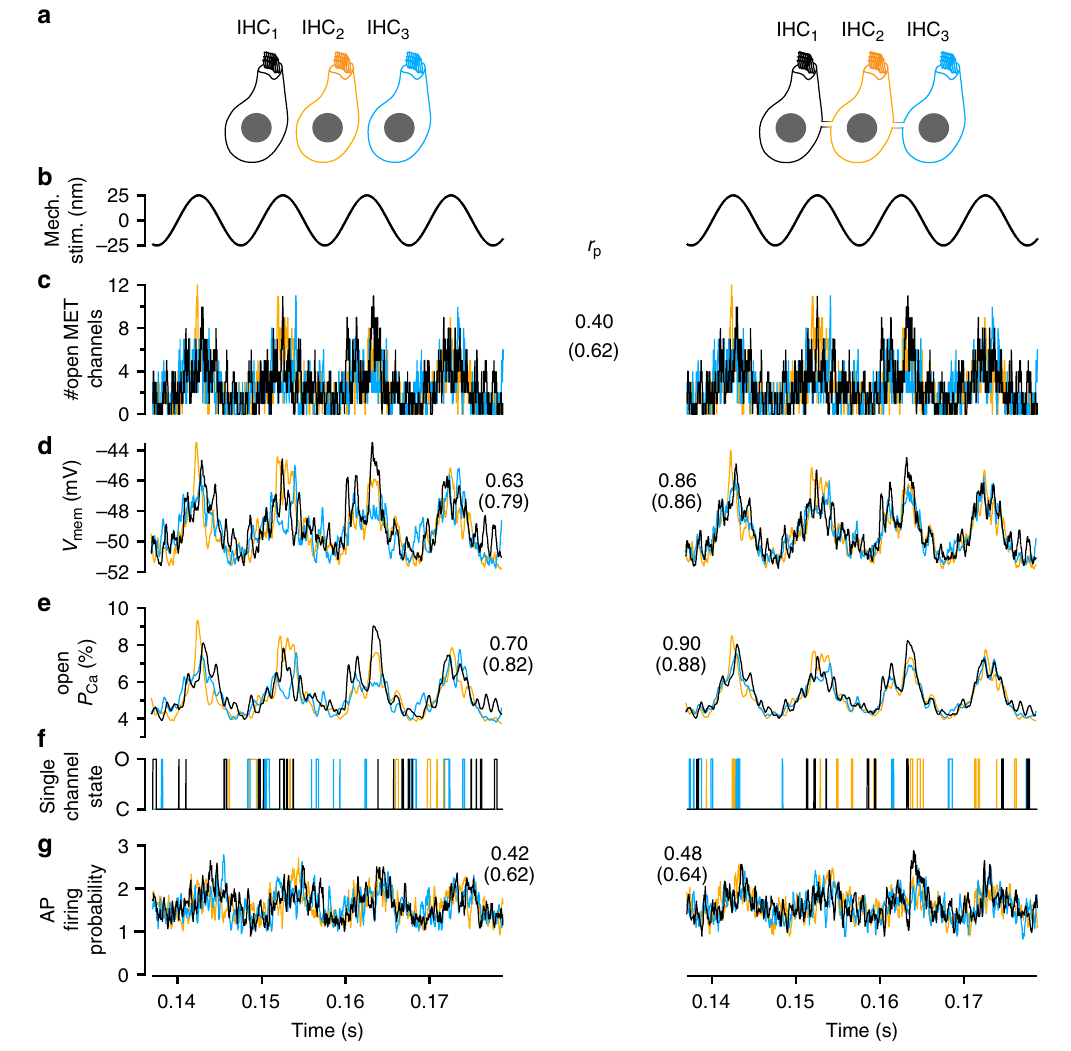
Fig. 8 Electrical IHC coupling coordinates Ca 2 + channel activity. The signaling steps of IHCs and their synapses, simulated in the Neuron modeling environment for three non-coupled IHCs (left) and three coupled IHCs with a junctional resistance of 25 M Ω (right). a Simpli fi ed representation of IHCs, color-coded for the simulation results presented below. b Depiction of the sinusoidal mechanical stimulus (identical for all three cells). c Realization of the stochastic gating of mechanotransducer channels (speci fi c for each cell, identical for coupled and uncoupled cells). d Membrane voltage variations of the three IHCs. They differ from each other because the mechanotransduction currents differ, but that difference is mitigated by electric coupling (right). e Illustration of the average open probability, as would result from very many realizations of Ca 2 + channel gating given the voltage trajectories above. f Different conductance states (O open, C closed) of one channel in each IHC. g Modeling stimulus-secretion-coupling and refractoriness for 35,000 independent realizations of ( f ), an approximate probability to observe an AP in a SGN during a 200 µ s window is calculated. Numbers in the central column are Pearson correlation coef fi cients r p , averages of correlations between pairs of traces from two different IHCs. In parenthesis are the average correlations between the IHC parameter and the sinusoidal stimulus. For those correlations, time lags of 0.3 ms for the voltage and 0.5 ms for the Ca 2 + channels are compensated for. AP action potential, IHC inner hair